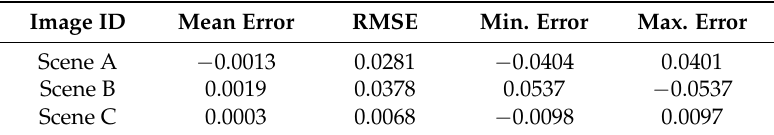
Table 8. Comparison statistical results (unit: